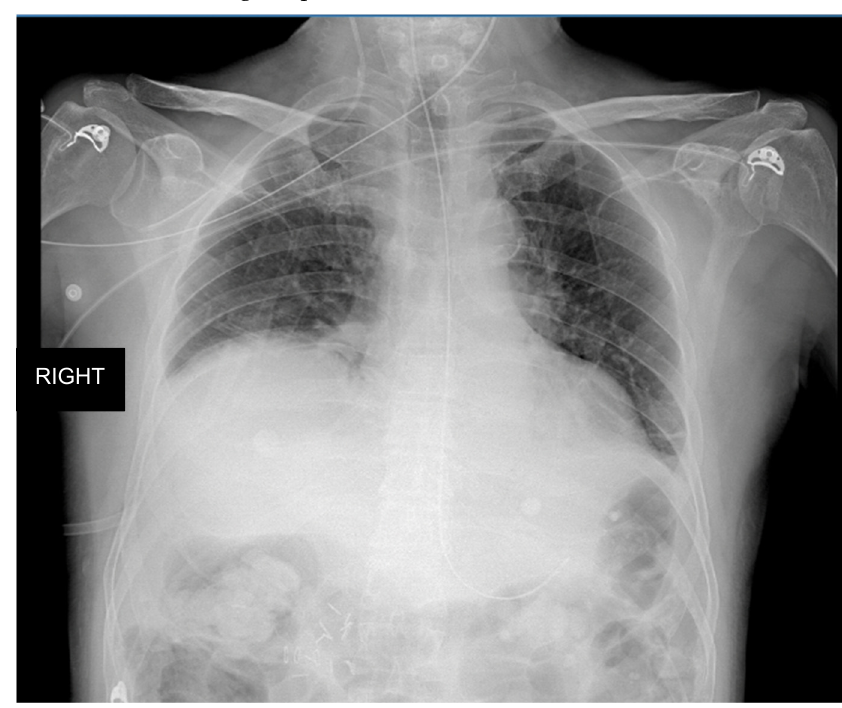
Figure 4. Chest X-ray performed in our unit after clinical worsening of the patient, which documented the presence of right hemidiaphragm elevation.